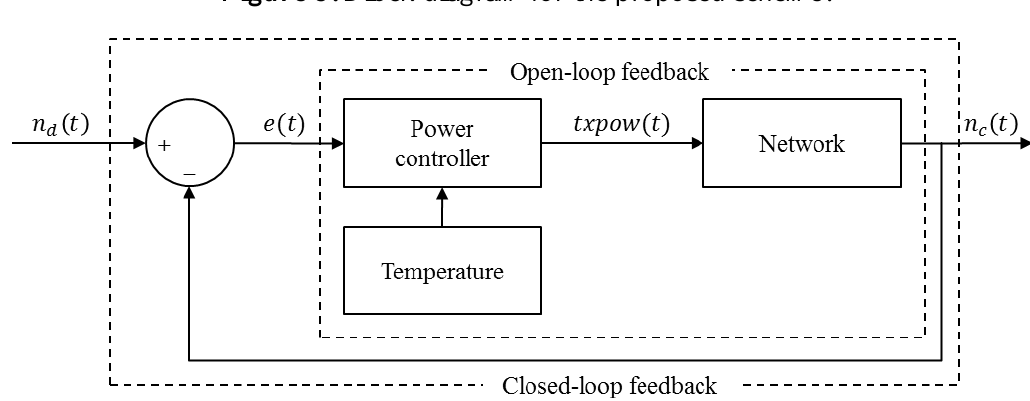
Figure 5. Block diagram for the proposed